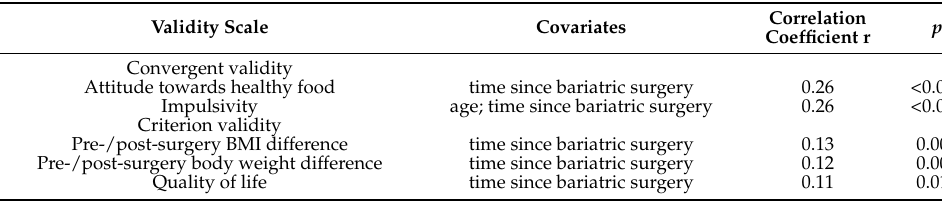
Table 6. Partial Pearson correlation analyses of the DBI-S clusters.